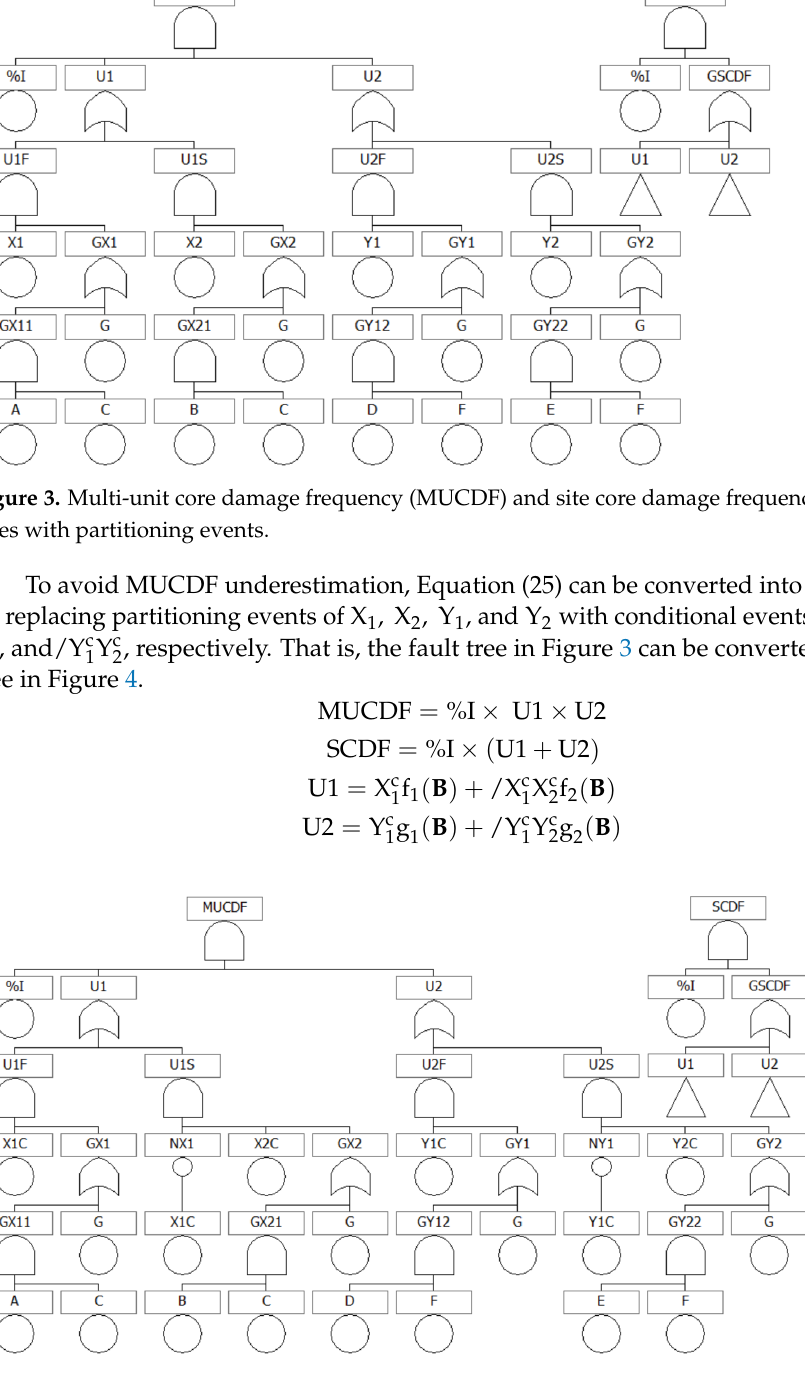
Figure 4. MUCDF and SCDF fault trees with explicit conditional events.